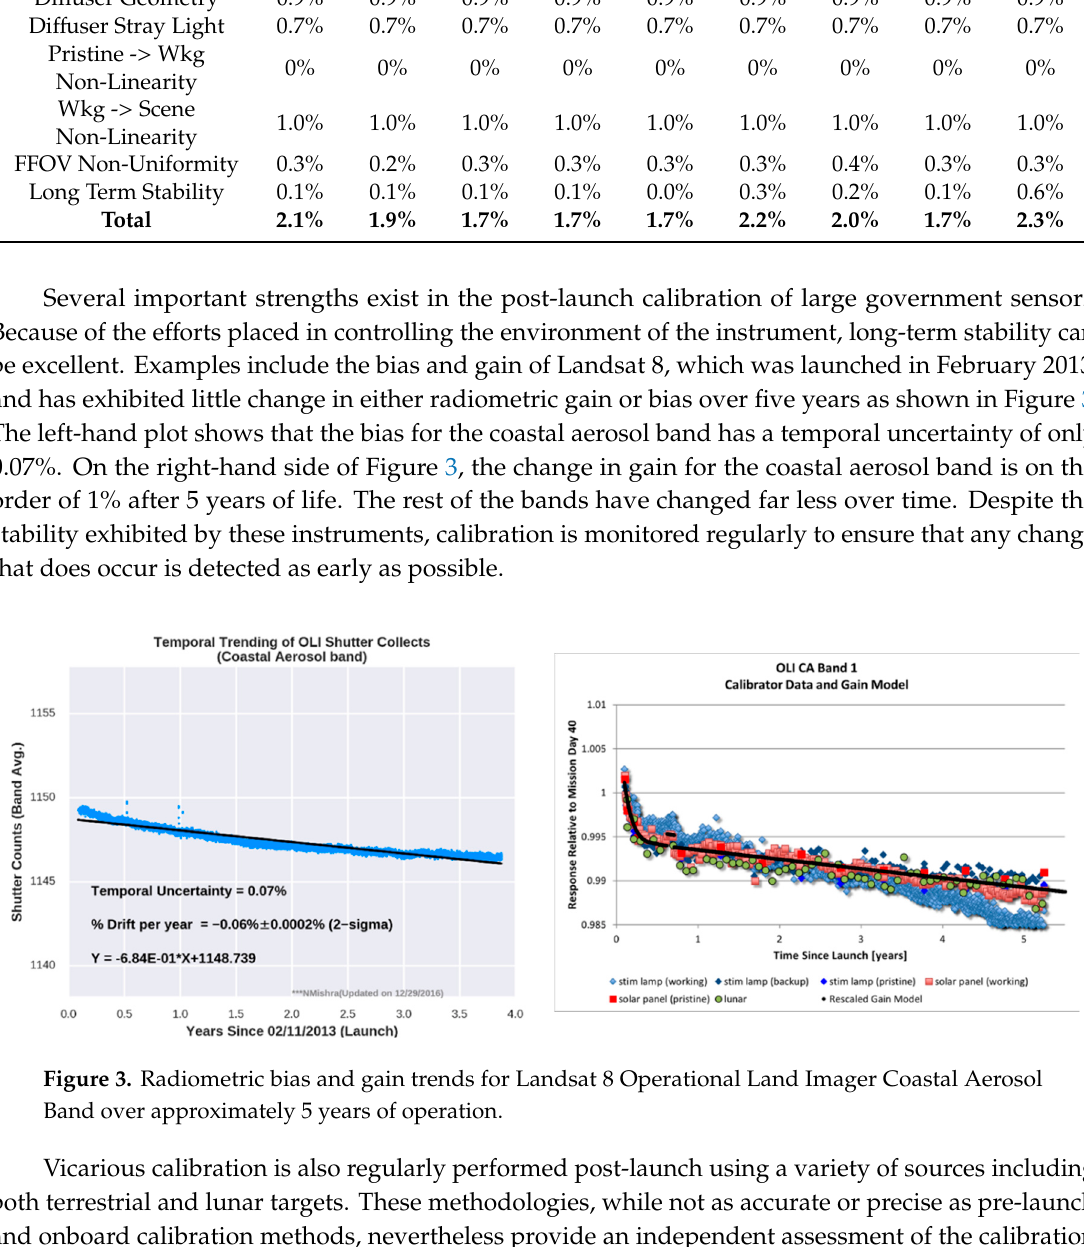
Table 2. Prelaunch reflectance-based calibration uncertainty for Landsat 8 OLI.